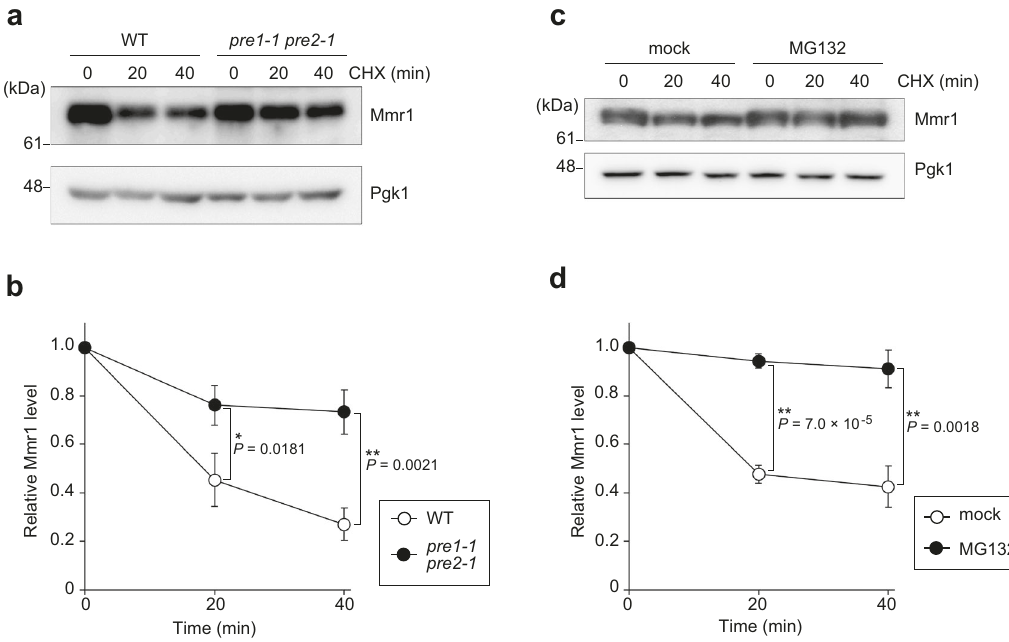
Fig. 1 Mmr1 is degraded by the proteasome. a JB291 (WT) and JB290 ( pre1-1 pre2-1 ) cells were grown to log phase in YPD medium at permissive temperature (25 °C), further incubated for 2 h at the restrictive temperature (37 °C), treated with cycloheximide (CHX), and harvested. Their total lysates were subjected to immunoblot analysis with anti-Mmr1 or, to demonstrate uniform loading, anti-Pgk1 antibody. b Mmr1 level was measured, normalized with that of Pgk1, and shown as a relative value to that at 0 min. c YTK4652 ( pdr5 Δ ) cells were grown to log phase in YPD medium at 30 °C, treated with MG132 or mock-treated with dimethylsulfoxide for 40 min, treated with CHX, and harvested. Their total lysates were subjected to immunoblot analysis using anti-Mmr1 or anti-Pgk1 antibodies. d Mmr1 level was measured, normalized with that of Pgk1, and shown as a relative value to that at 0 min. Values in ( b ) and ( d ) represent the mean ± SD from three independent experiments. An unpaired two-tailed t test was used for the statistical